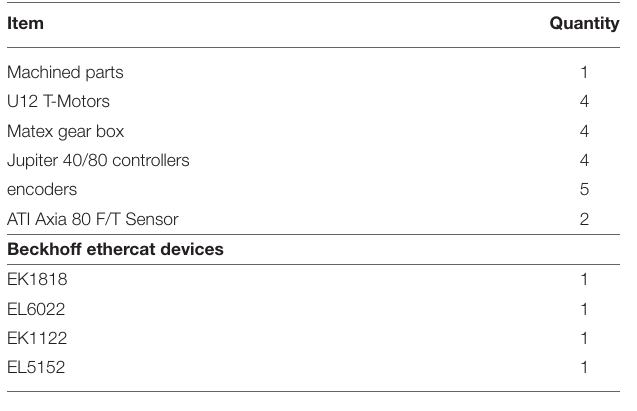
TABLE 1 | Hardware components.